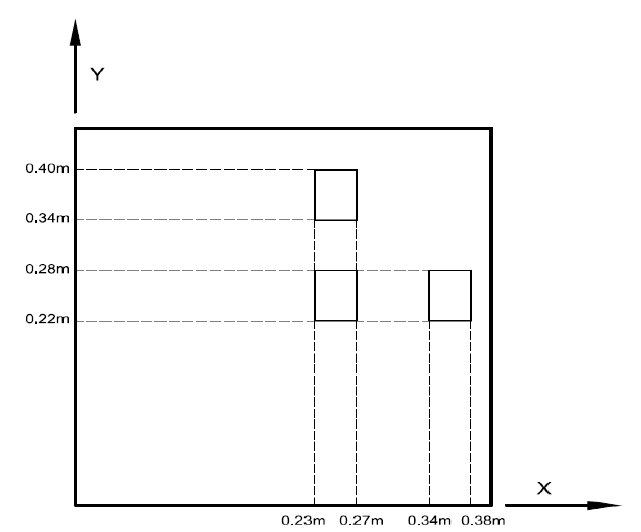
Figure 8. PZT actuator surface bonded on the composite laminate plate at three different locations.